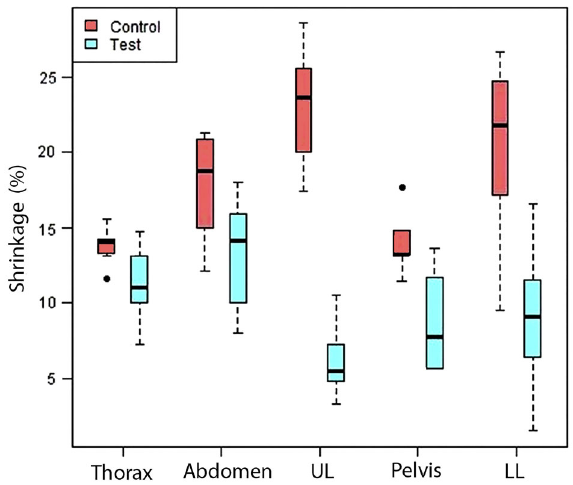
Figure 3. Comparison of percent volumetric shrinkage by anatomical segment. Control: S10 silicone; Test: P1 silicone. Data are reported as median and interquartile range. Between- group differences were all signi fi cant (P o 0.05; Kruskal-Wallis test). UL: upper limb; LL: lower